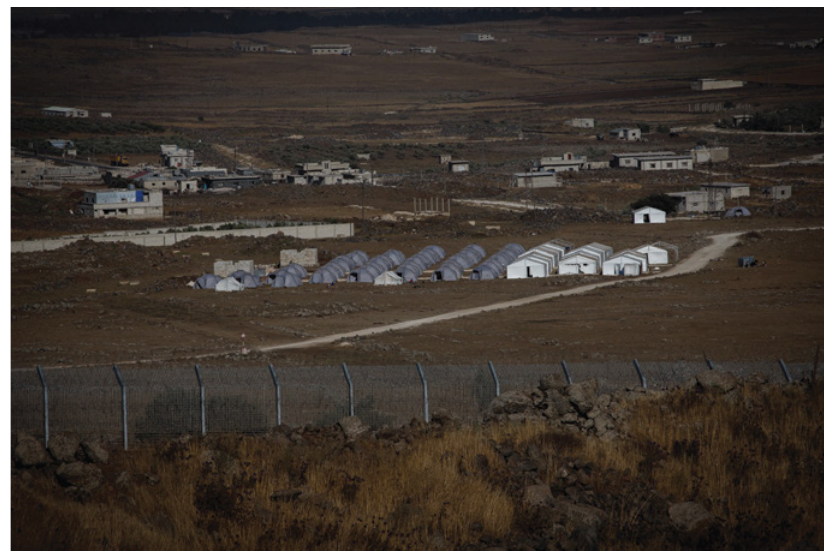
Figure 1. A general view of a refugee camp on the Syrian side of the Israeli-Syrian border, in the Golan Heights near the Syrian village of Aesheh, June 27, 2014. Photo by: Ancho Gosh and Gil Eliyahu –